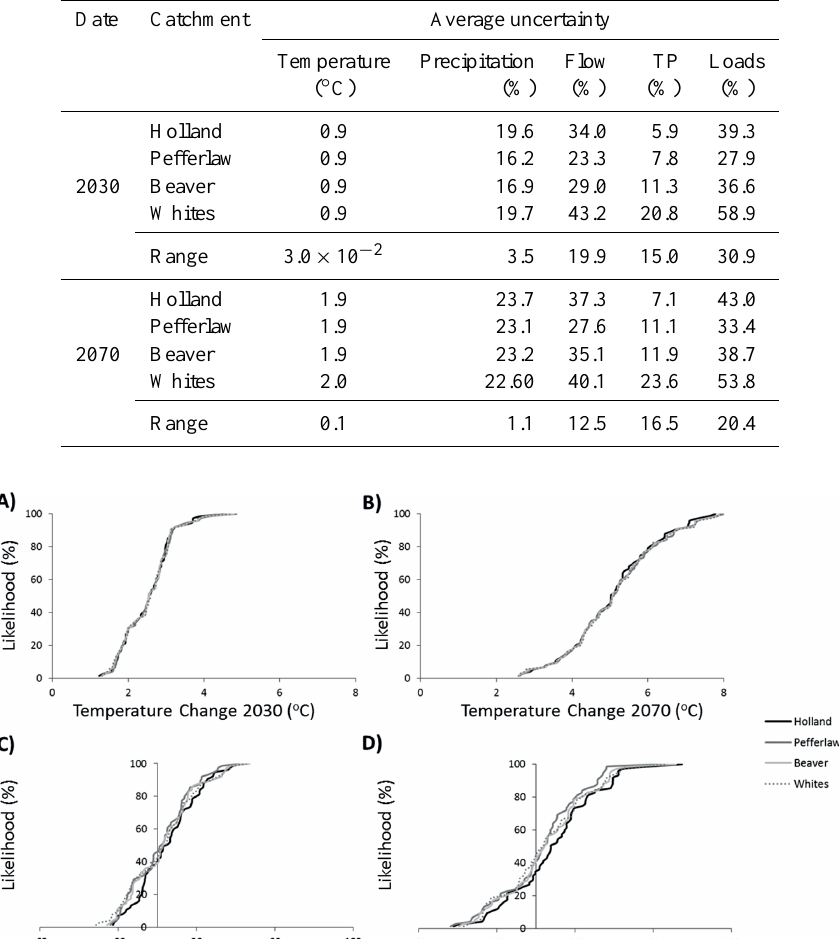
Table 6. A measure of average uncertainty of temperature, precipitation, flow, TP concentrations and loads across the perturbed physics ensemble, where “average uncertainty” is calculated as the mean value of uncertainty across all probability levels within the cumulative distribution function (1d.p.).